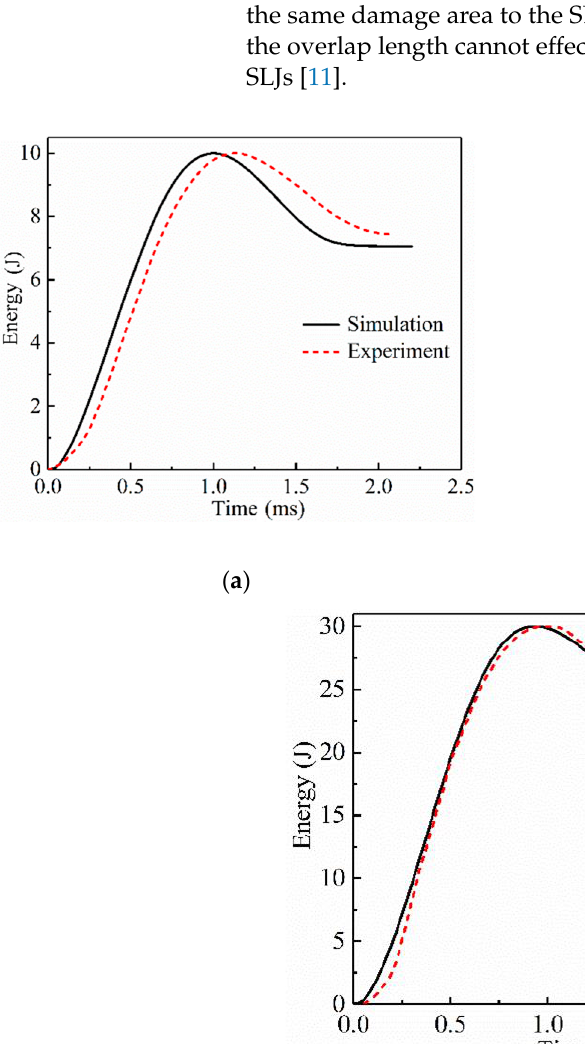
( b ) Figure 8. The influence of different overlap lengths and impact energies on the impact resistance of SLJs: ( a ) Peak force at different impact energies and ( b ) Absorbed energy at different impact energies.